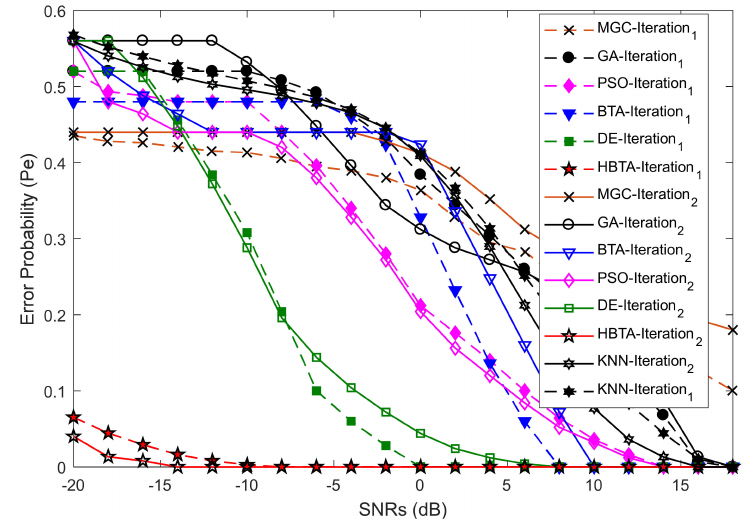
Figure 15. Error probability vs. SNRs in the presence of AO-AOC users with sensing iterations 1 (60) and iterations 2